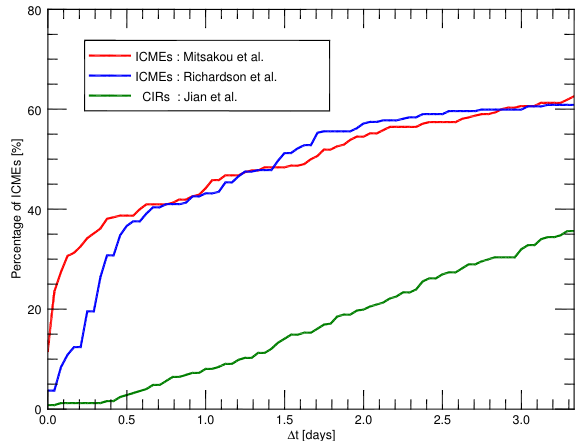
Figure 5. Percentage of events involved in a sequence according to (cid:49)t . Two events are involved in a sequence if they are separated by less than (cid:49)t days. For comparison purpose, the red and blue lines give the results for two lists: Mitsakou and Moussas (2014b) (in red) and Cane and Richardson (2003) (in blue). We also added the results for a list of CIRs from Jian et al. (2006) study (in green).